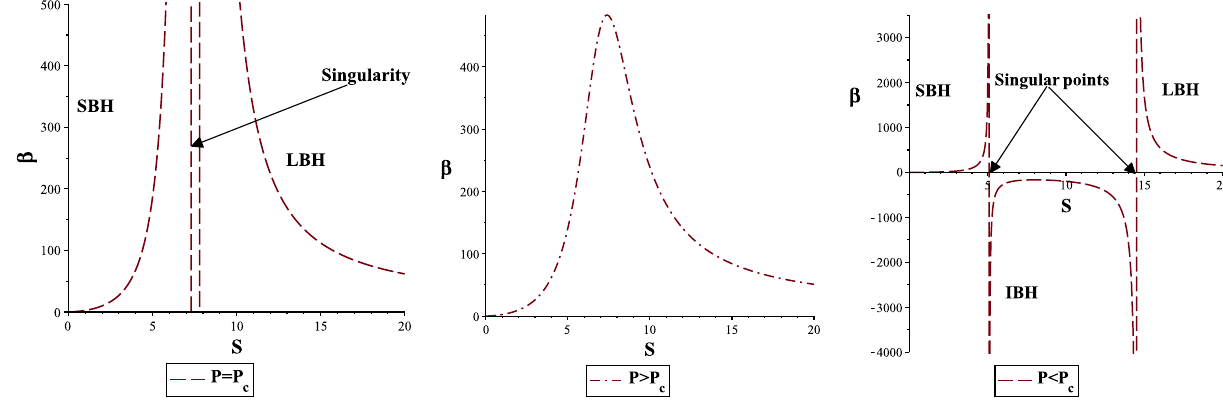
Fig. 11 β versus S with a 2 = 1, e = 0 . 2 and g = 0 . 6. Left panel: P = P c , middle panel: P > P c and right panel: P < P c